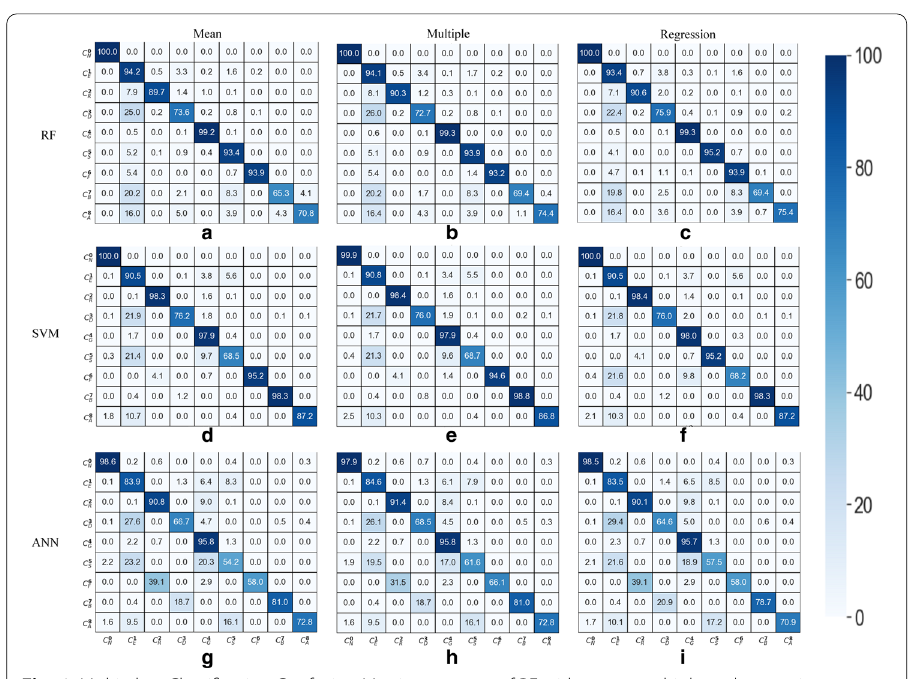
Fig. 6 Multi-class Classification Confusion Matrices. a – c are of RF with mean, multiple and regression imputation, d – f are of SVM with mean, multiple and regression imputation and g – i are of ANN with mean, multiple and regression imputation. In C i j , C is class, i is the label which is from 0-8 and j shows that 0 is normal and 1 is exploits (E), 2 is reconnaissance(R), 3 is DoS(D), 4 is generic(G), 5 is shellcode(S), 6 is fuzzers(F), 7 is backdoor(B) and 8 is analysis(A)